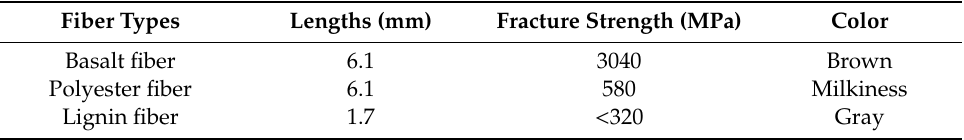
Table 5. Physical and mechanical properties for three kinds of fibers.